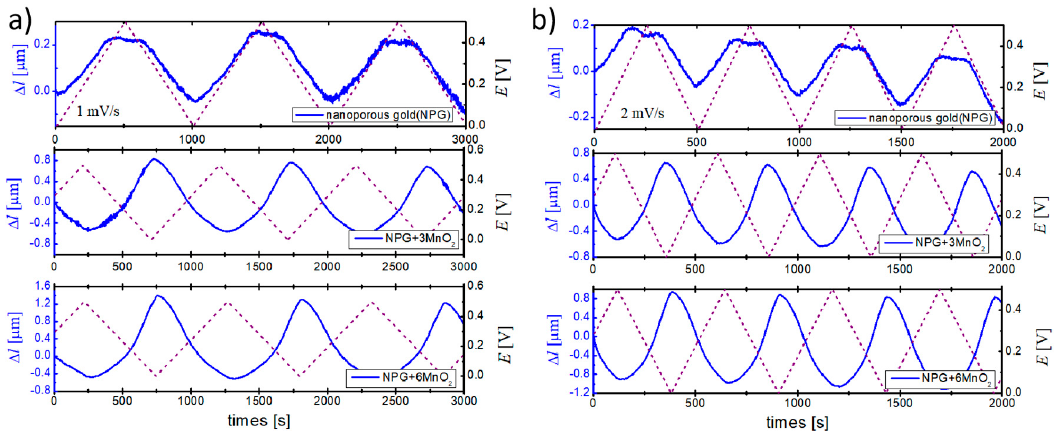
Figure 2. The length change (blue solid line) of three different samples (npg, npg+3MnO 2 , and npg+6MnO 2 ) in response to the change in electrochemical potential (dotted line) in the time domain at a potential scan rate of 1 mV s − 1 ( a ) and 2 mV s − 1 ( b ).